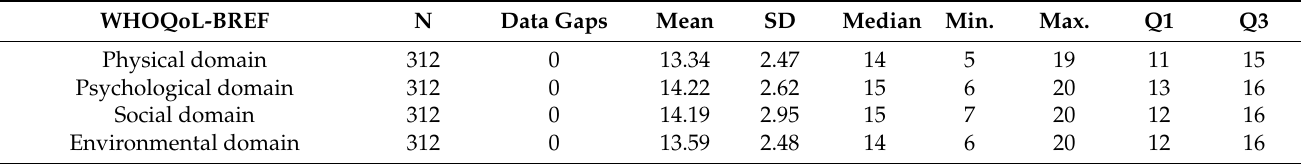
Table 5. QoL in individual domains of the WHOQoL-BREF